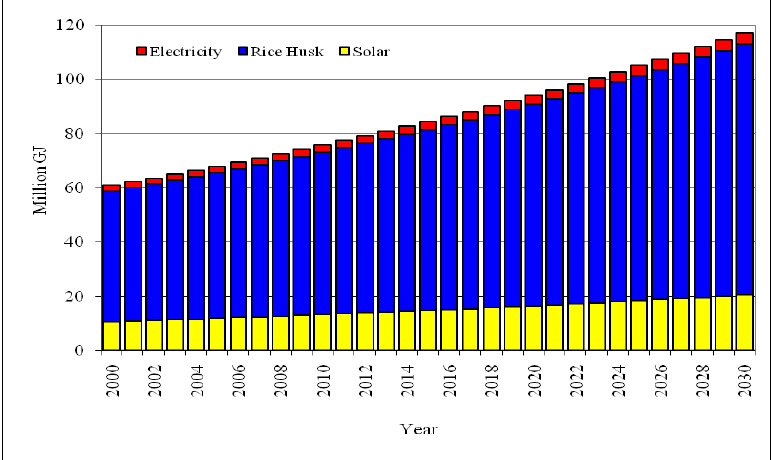
Figure 3. Final energy demand for rice food grain processing in